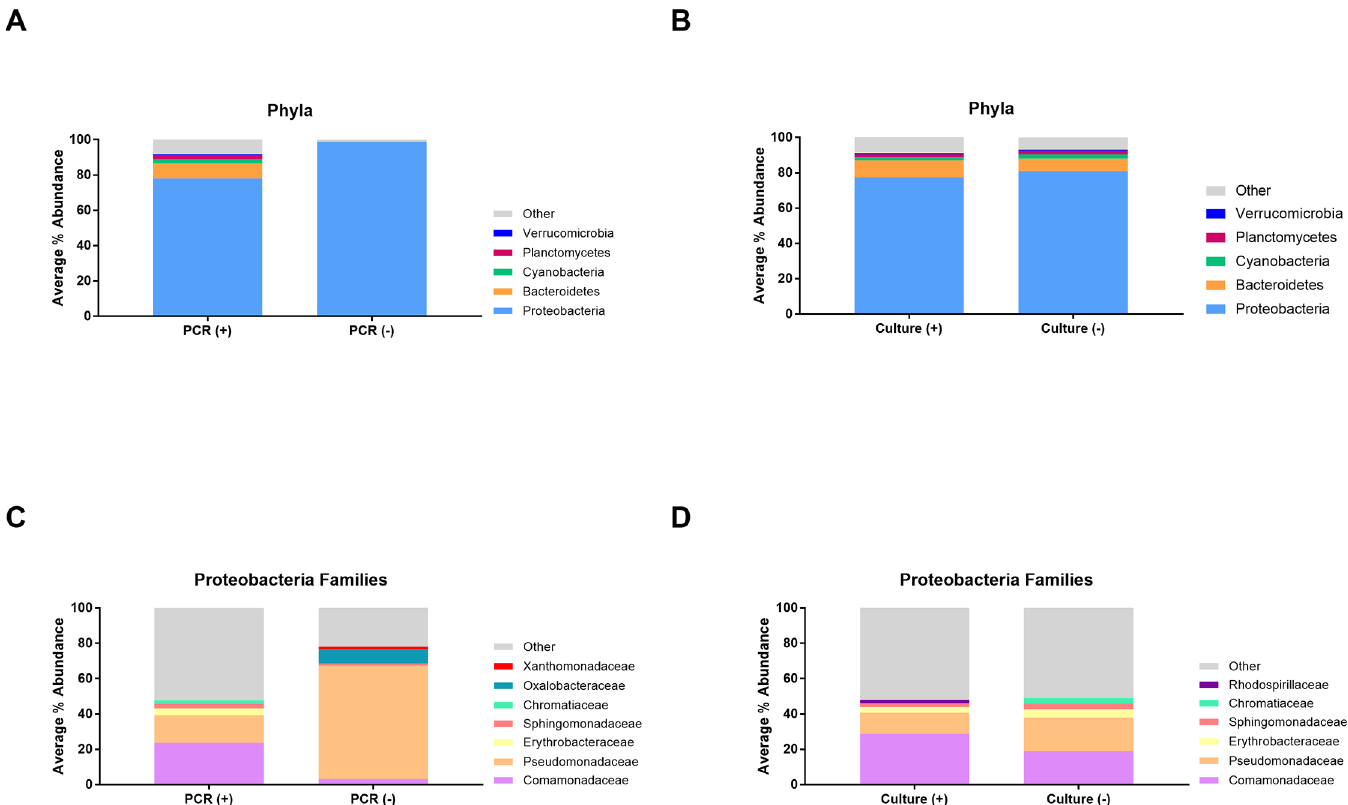
Fig 4. Phyla and Proteobacteria family profiles related to PCR and culture results. The composition of the five most abundant phyla (A, B) and five most abundantProteobacteria families (C, D) present in coolingtower water samples were comparedby overall Legionella PCR result (A, C) and culture result (B, D). Note that only samples that were positive by PCR underwent